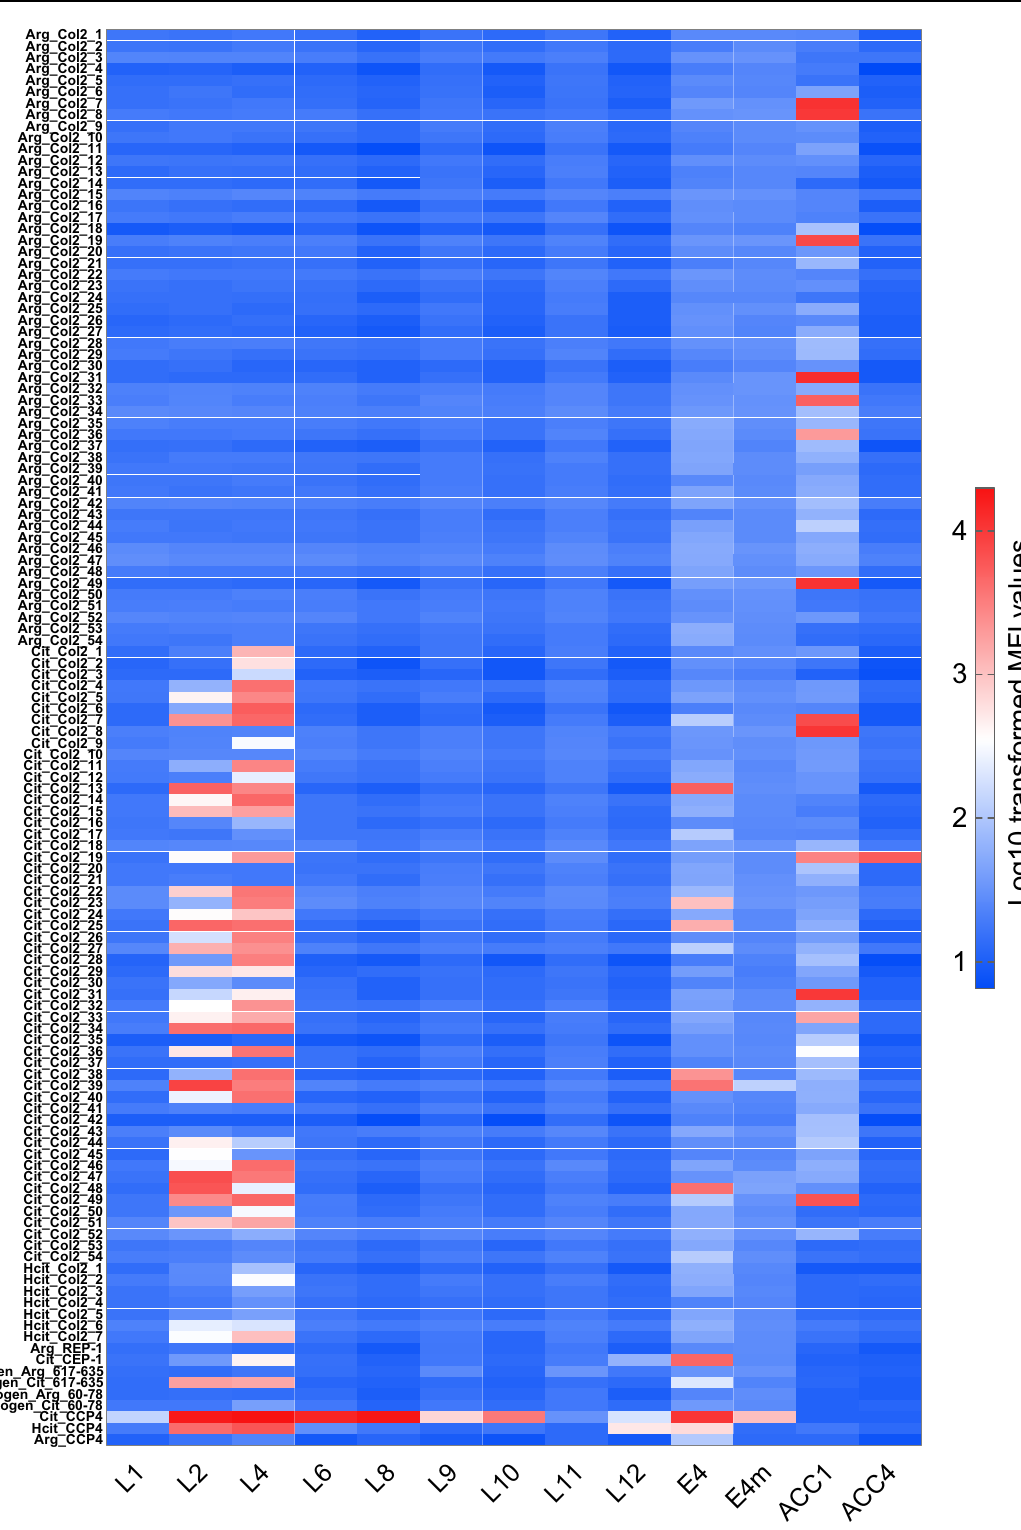
Fig. 1 | Reactivity of monoclonal antibodies to modi fi ed/non-modi fi ed cyclic peptides. A library of 108 cyclic 17-mer COL2 peptides covering the whole sequence of mature human COL2 was synthesized (54 citrullinated and 54 corre- sponding non-modi fi ed arginine COL2 peptides) along with other indicated